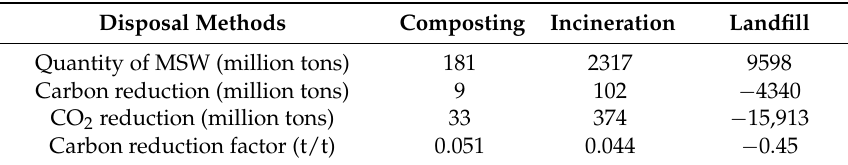
Table 4. Carbon reductions of each MSW treatment method in China